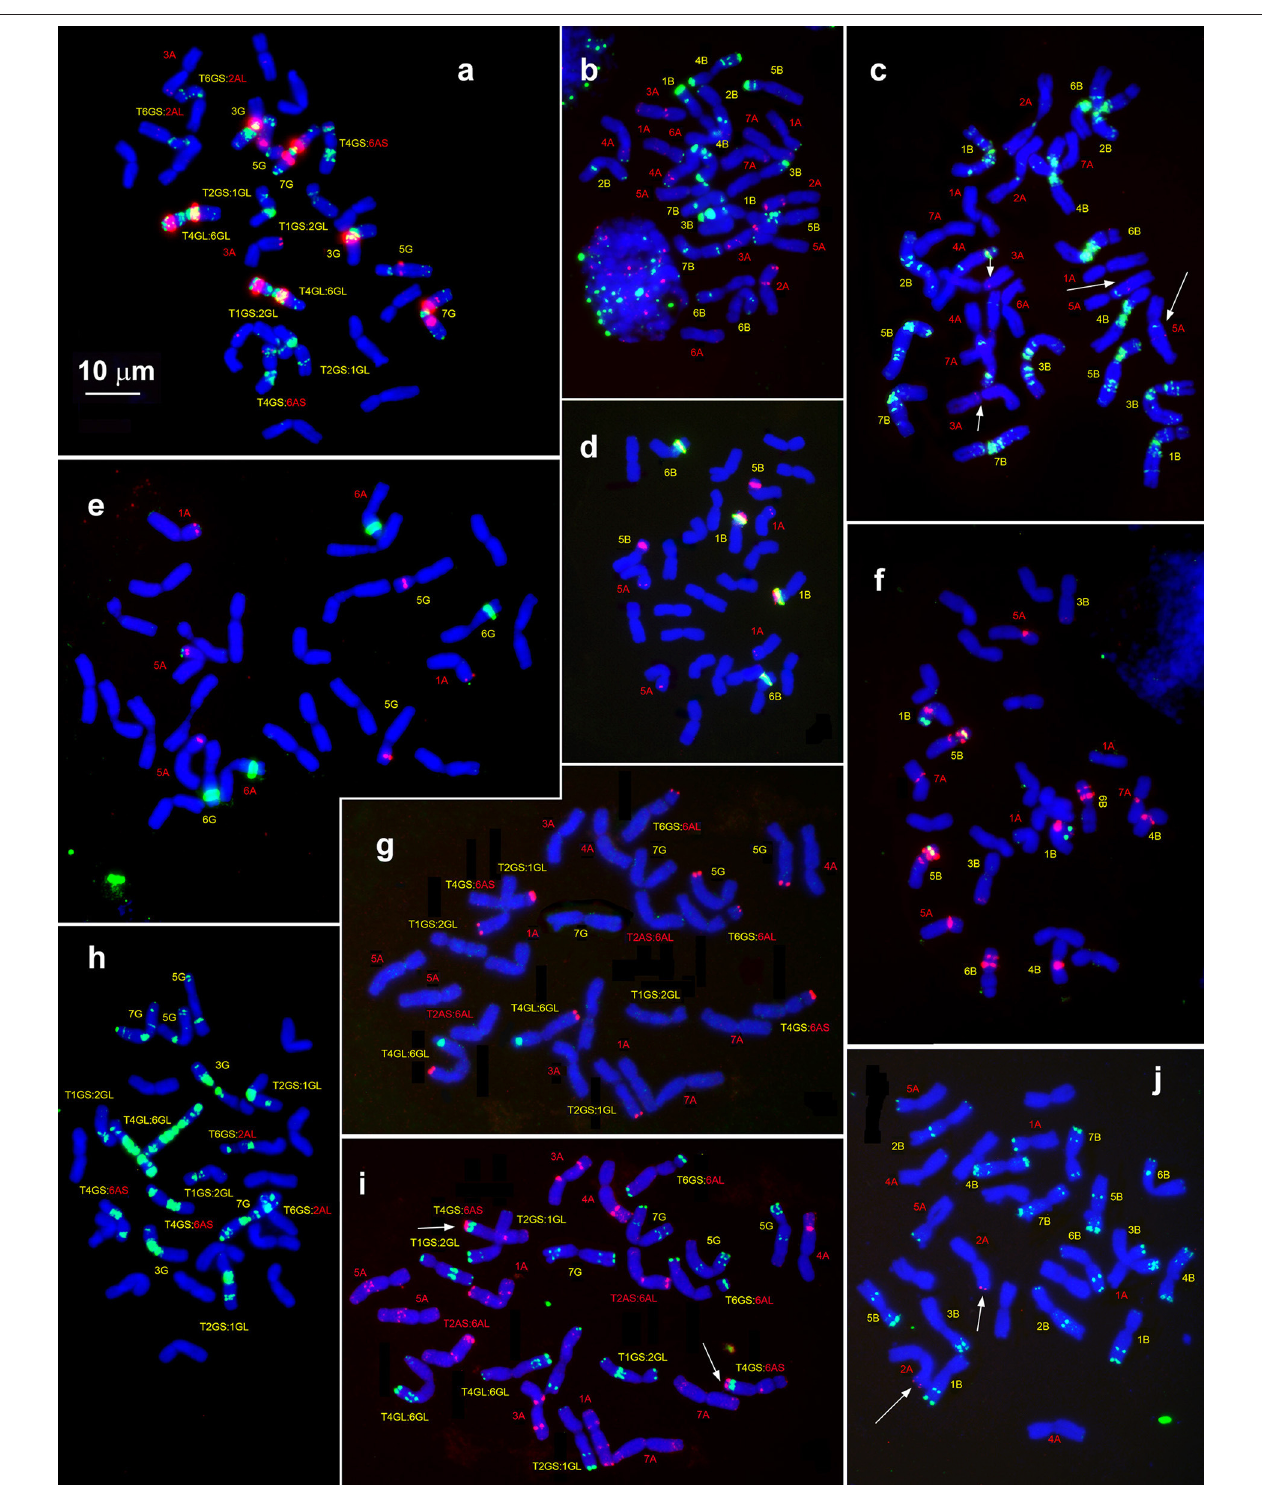
FIGURE 6 | Hybridization patterns of (CTT) 10 ( a,c,h , green), pSc119.2 ( b,i,j , green), pTa-535 ( c,i , red), pTa-s53 ( b,h , red), pAesp_SAT86 ( f,h , red), NORs ( d,e , green), and 5S rDNA ( d,e , red), 5S rDNA ( f , green); Spelt-1 ( j,g , red) and Spelt-52 ( g , green) on metaphase chromosomes of T. dicoccoides, IG 46396 (b–d,f,j) and T. araraticum, K-59940 (a,e,h,g,i) . Position of pTa-s53 hybridization sites on T. dicoccoides chromosomes (c) , huge cluster of pTa-535 sequence on the chromosome 4GS (i) and Spelt-1 site on T. dicoccoides chromosome 2AL (j) are indicated with arrows. Scale bar, 10 µ m.